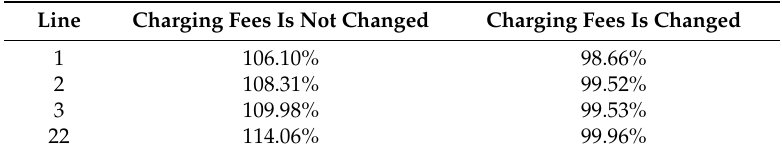
Table 4. Maximum line load rate of a congested line in a day before and after adjustment for charging fees.